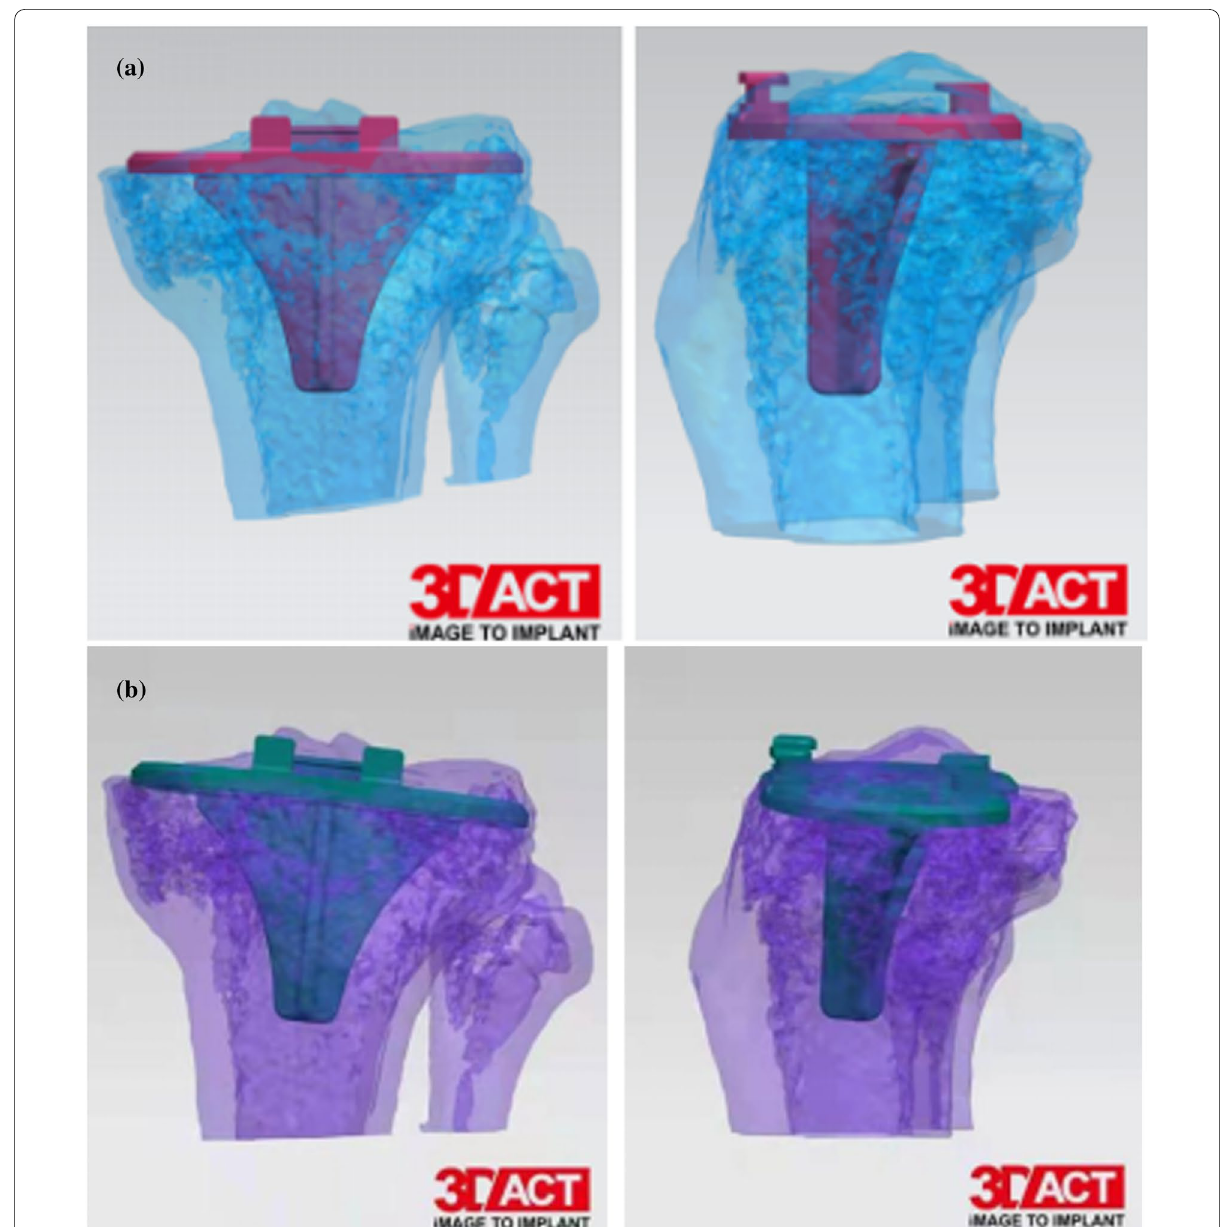
Fig. 4 Representative case study 4. A 62-year-old man. a Simulated operation and internal fixation based on standard-dose CT scan; b simulated operation and internal fixation based on ultra-low-dose CT scan. The internal fixation models of a and b are identical, and the operation method is the